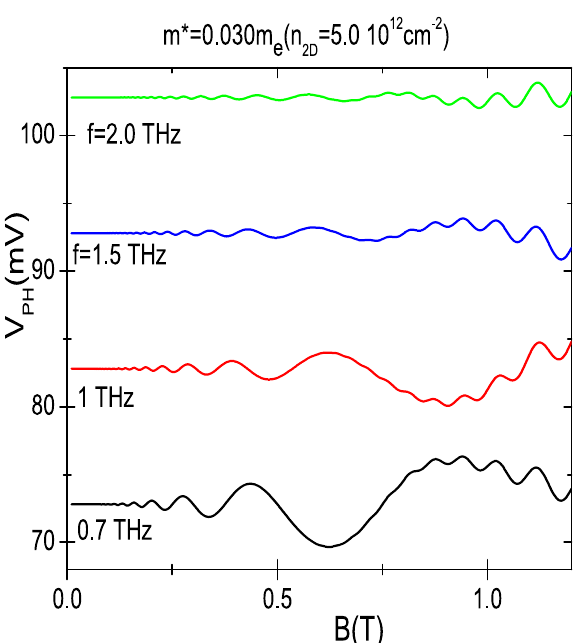
Figure 4. Frequency dependence of the calculated photovoltage vs B , showing four frequencies in the THz range: 0.7, 1, 1.5 and 2.0 THz. As the frequency rises the number of oscillations increases but the oscillations 1 amplitude lowers. T =